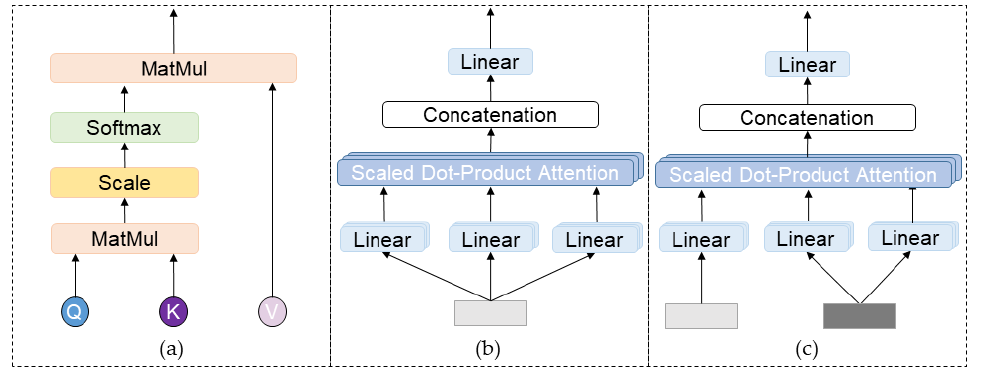
Figure 2. Structure of attention mechanism. ( a ) Scaled Dot-Product Attention. ( b ) Multi-head self-attention (MSA). ( c ) Multi-head cross-attention